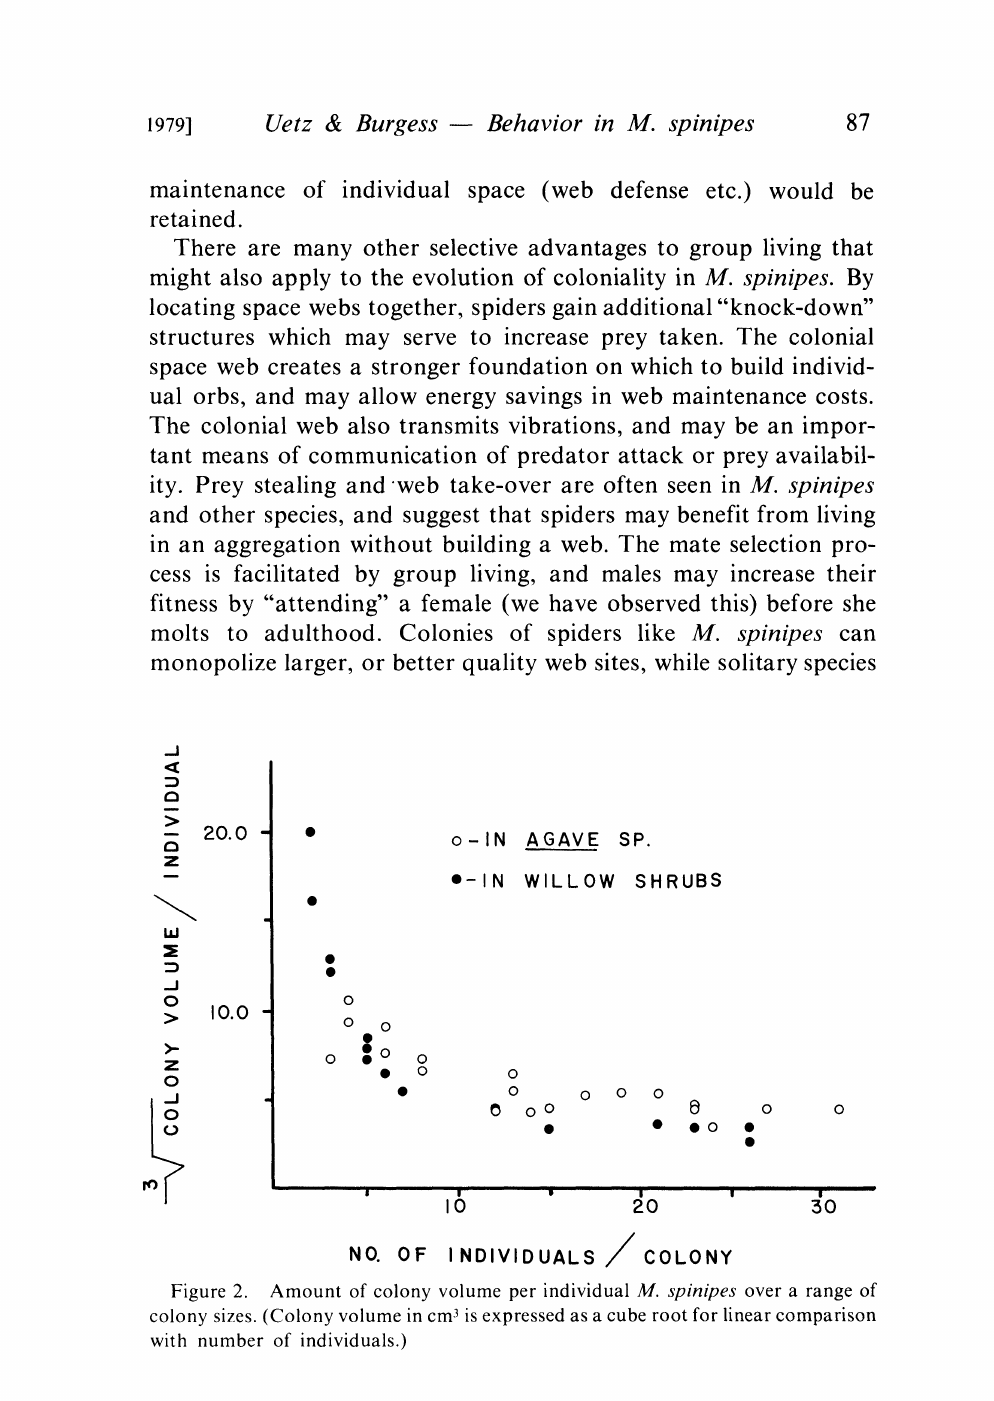
Figure 2. Amount of colony volume per individual M. spinipes over a range of colony sizes. (Colony volume in cm is expressed as a cube root for linear comparison with number of